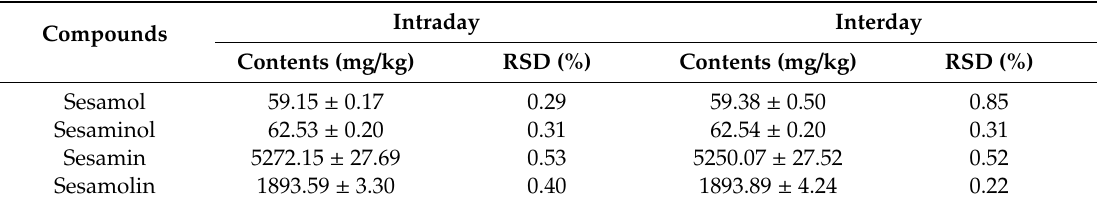
Table 3. Precision of the intraday and interday high-performance liquid chromatography (HPLC) measurement for individual lignans.